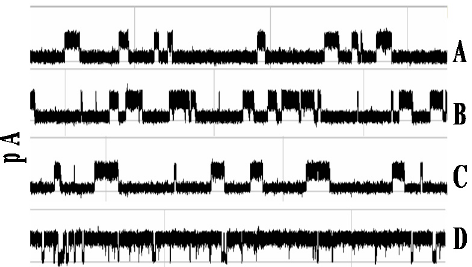
Figure 3. Antibody-Antigen binding—clear example from specific capture orientation [19]. Each trace shows the first 750 ms of a three-minute recording, beginning with the blockade signal by an antibody molecule that has inserted (some portion) into the α -hemolysin channel to produce a toggle signal ( A–C ). Antigen is introduced at the beginning of frame ( A ). Changes to the toggle signal are discernible in frame ( D ), indicating the binding event between the antibody and antigen has taken place.